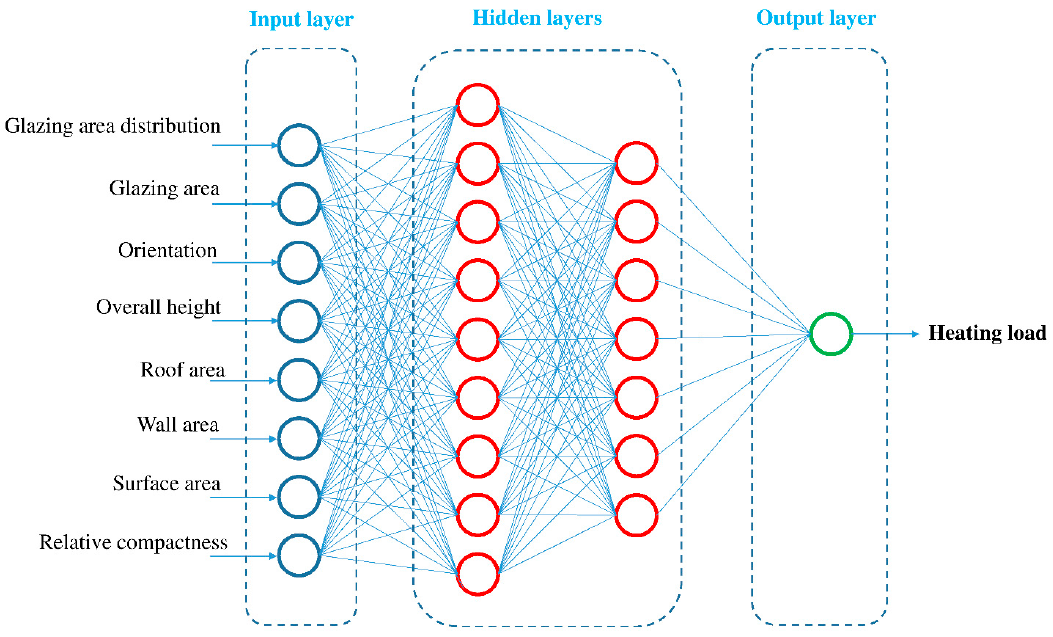
Figure 5. Framework of artificial neural network (ANN) model for estimating heating load (HL) of buildings’ energy efficiency (EEB) systems.